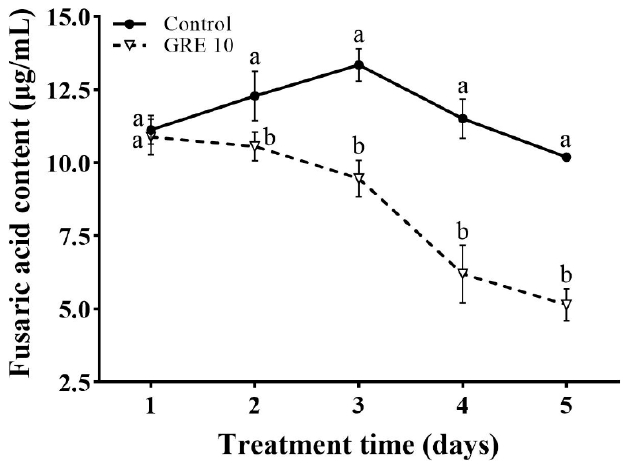
Figure 6. Effect of 10 mg/mL GRE on the FA content in F. solani. The bars on the curves represent standard deviations, and different letters at the same time point represent significant differences ( p < 0.05).